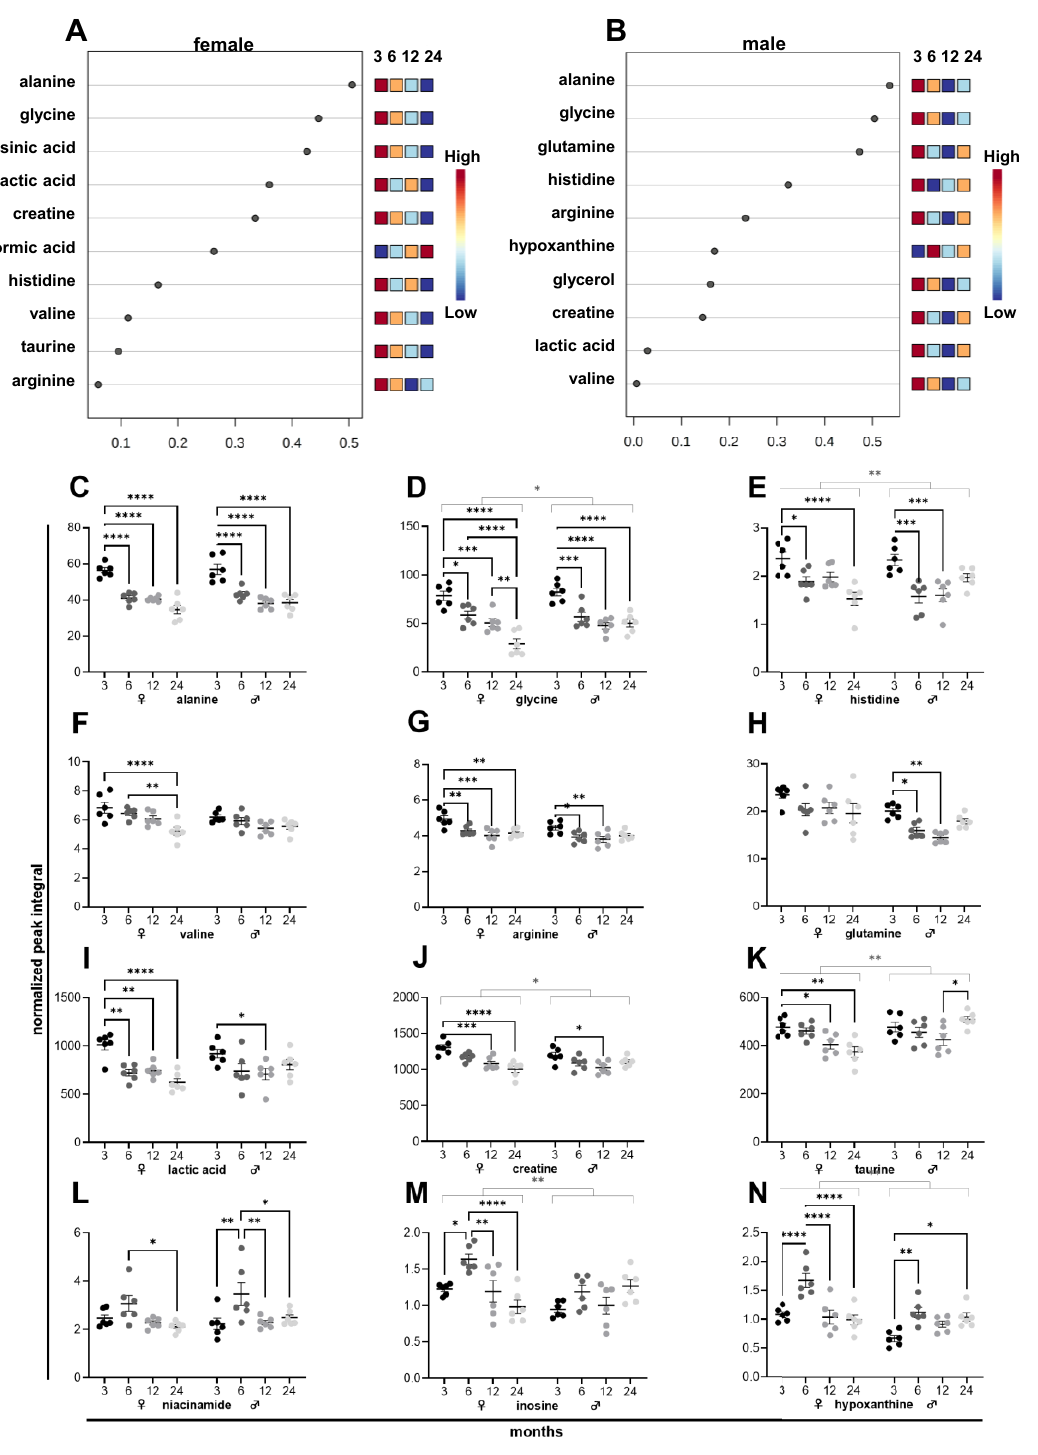
Figure 6. NMR metabolomics of female and male murine skeletal muscle samples. Metabolites of six female ( A ) and six male ( B ) mice ranked based on the variable importance during projection (VIP) score as a function of age. Individual metabolite levels of female (left) and male (right) tissues at 3, 6, 12, and 24 months presented as normalized peak integral ( C – N